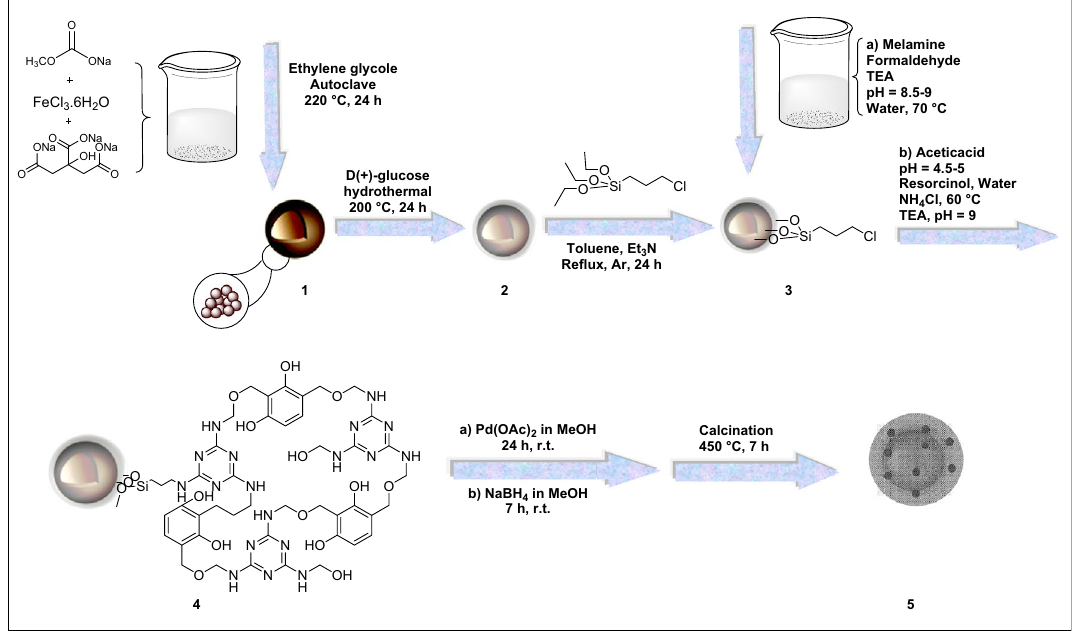
Figure 4. The possible formation process of Pd@h-Fe 2 O 3 @C